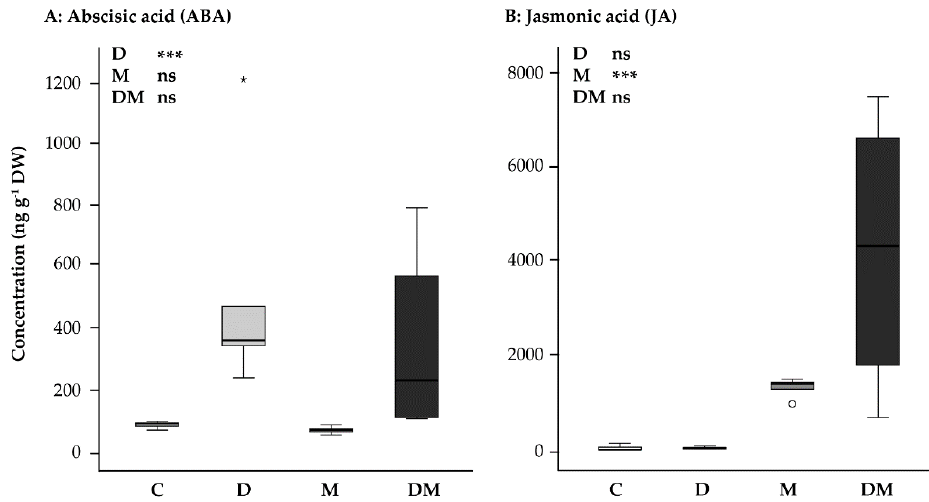
Figure 1. Effect of application of drought (D) and MeJA (M), separately and combined (D + M), on phytohormone levels in Picea glauca needles: ( A ) Abscisic acid (ABA), ( B ) Jasmonic acid (JA) at second sampling-point. Results of a two-way ANOVA are shown on the upper right: ns, not significant; ***, p < 0.001; white circles indicate outliers and asterisks indicate extreme values; C, control.